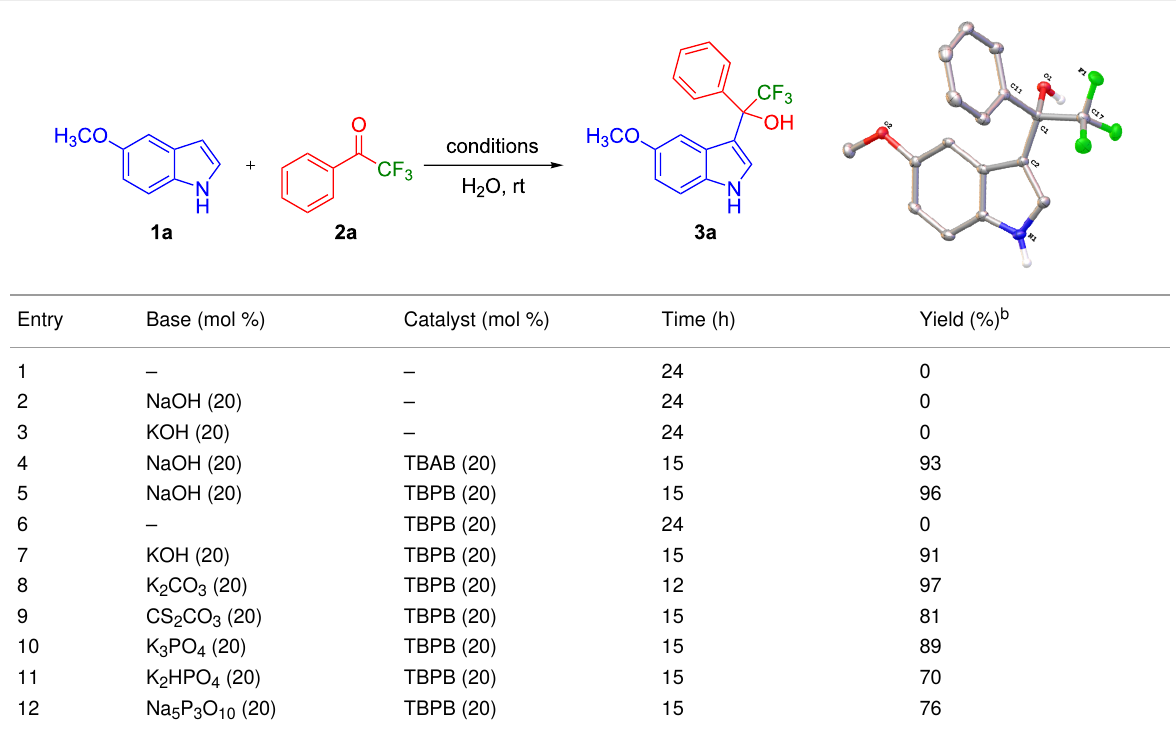
Table 1: Optimization of reaction conditions for the preparation of 2,2,2-trifluoro-1-(1 H -indol-3-yl)ethan-1-ol ( 3a ).